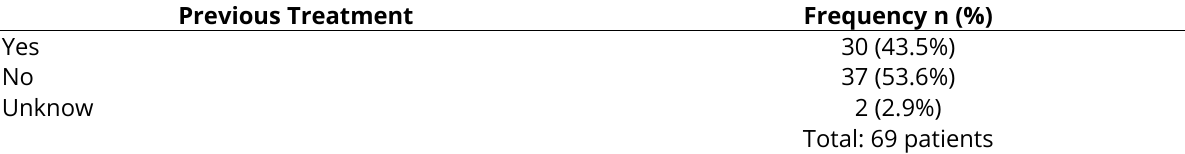
Table 3 - Previous treatment of DFSP treated at